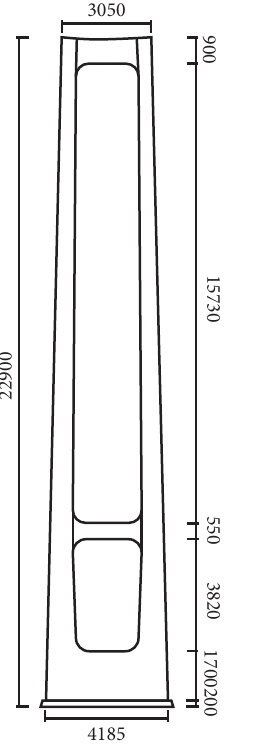
Figure 5: Layout of bridge tower (unit: